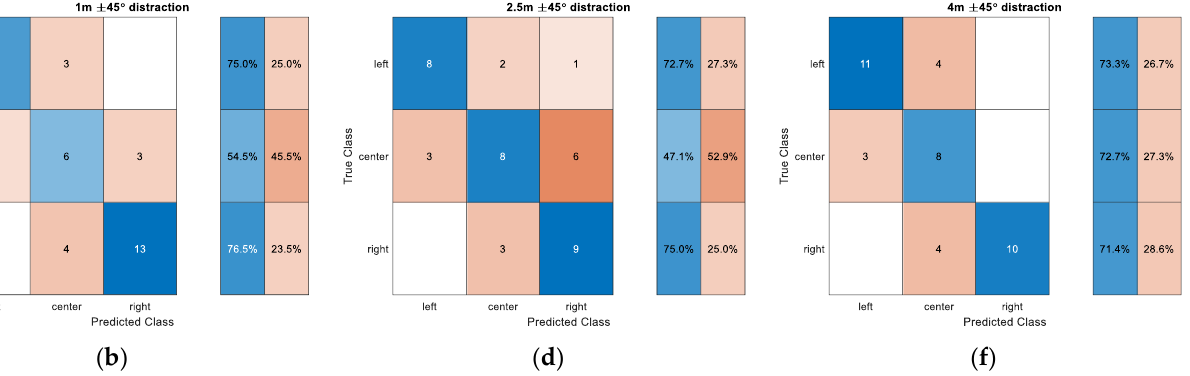
Figure 20. Confusion matrix for narrow angle situations : ( a ) 1 m and ±45° without distraction; ( b ) 1 m and ±45° with distraction; ( c ) 2.5 m and ±45° without distraction; ( d ) 2.5 m and ±45° with distraction; ( e ) 4 m and ±45° without distraction; ( f ) 4 m and ±45° with distraction.